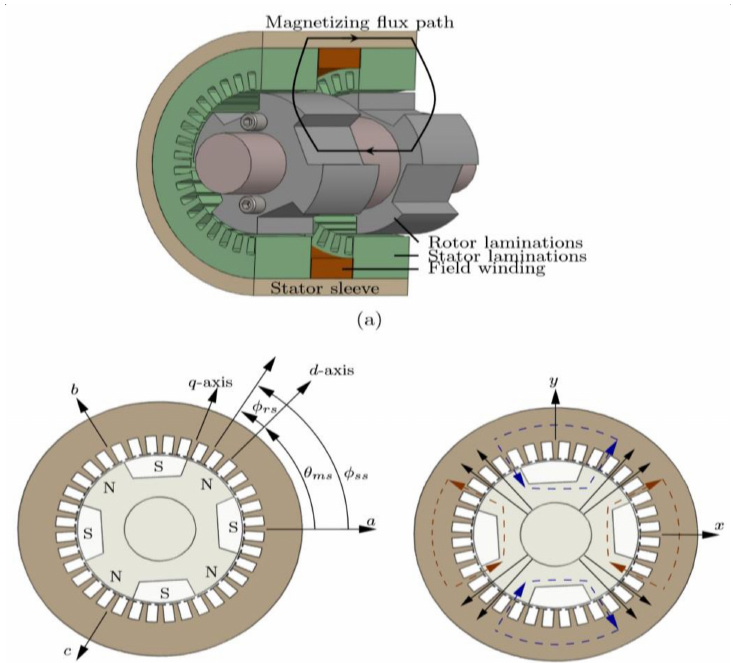
Figure 8. AC homopolar motor, adapted from